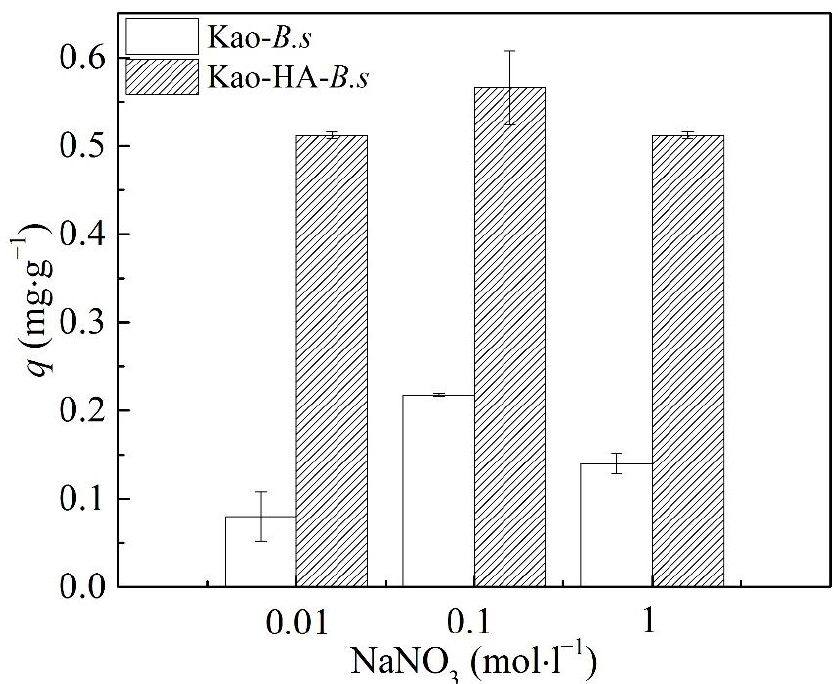
Figure 2. Effect of ionic strength on As(V) adsorption on Kao- B.s and Kao-HA- B.s (50:1:50) complexes (C 0 : 2.5 mg · L − 1 ; adsorbent dosage: 2.5 mg · L − 1 ; T: 25 ◦ C; pH: 5; t: 24 h). The amount of As(V) sorption with the Kao- B.subtilis and Kao-HA- B.subtilis (50:1:50) composites first increased and then decreased with ionic strength. The As(V) adsorp- tion capacity increased from 0.08 to 0.22 mg · g − 1 for the Kao- B.subtilis system and from 0.51 to 0.57 mg · g − 1 for the Kao-HA- B.subtilis ternary one with increasing ionic strength (from 0.01 to 0.1 mol · L − 1 ). The surface modification of kaolinite by humic acid could enhance the adhesion of B. subtilis , indicating that the dispersion effect of HA on kaolinite dominated the adsorption process. These trends are consistent with the previously reported